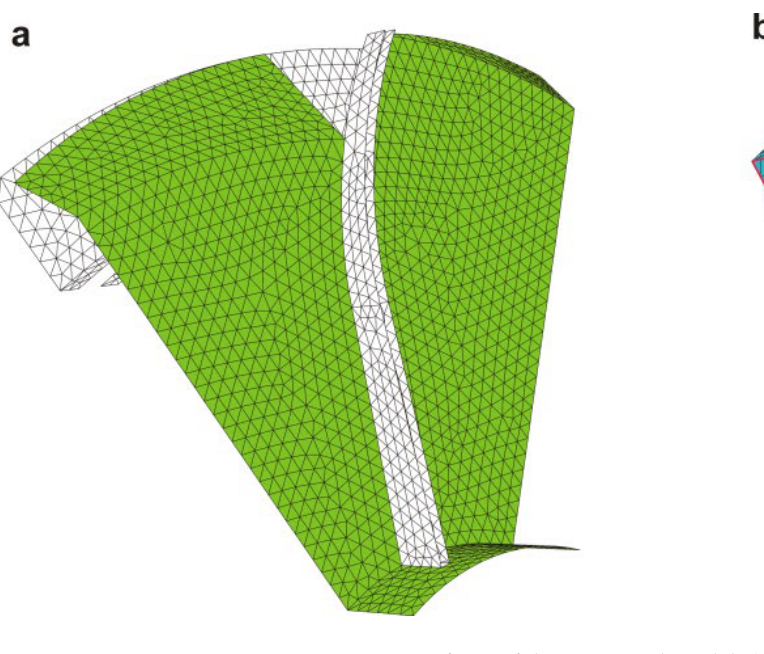
Figure 11. Surfaces of the numerical model: ( a ) without the top wall of the body; ( b ) with the top wall of the body.